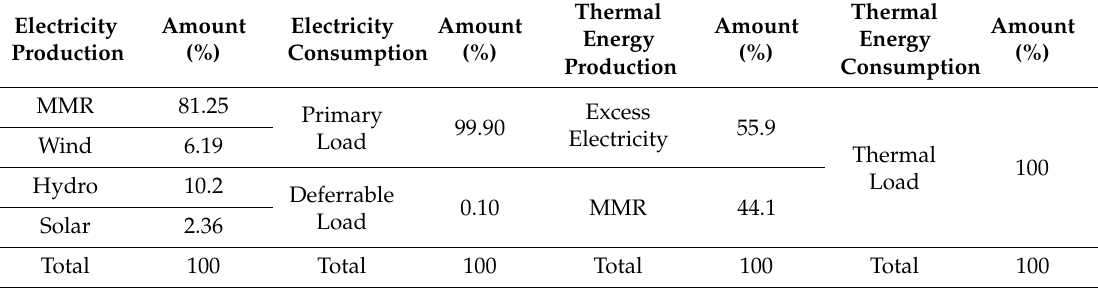
Table 16. Energy production and consumption scenario of o ff -grid mode for the first year of project life